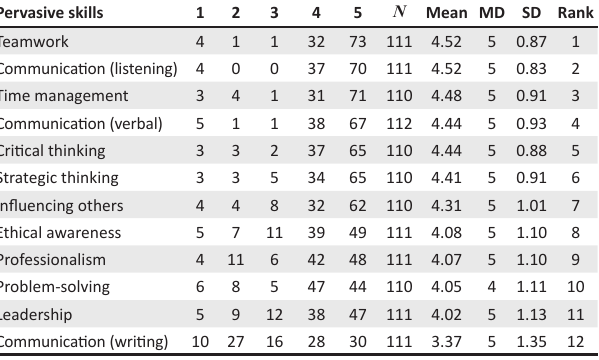
TABLE 2: Development of pervasive skills through the 60 seconds game (Accounting 200). Pervasive